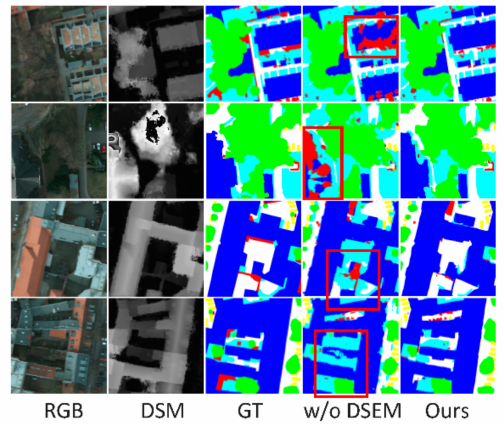
Figure 5. Ablation performance comparisons with the effect of